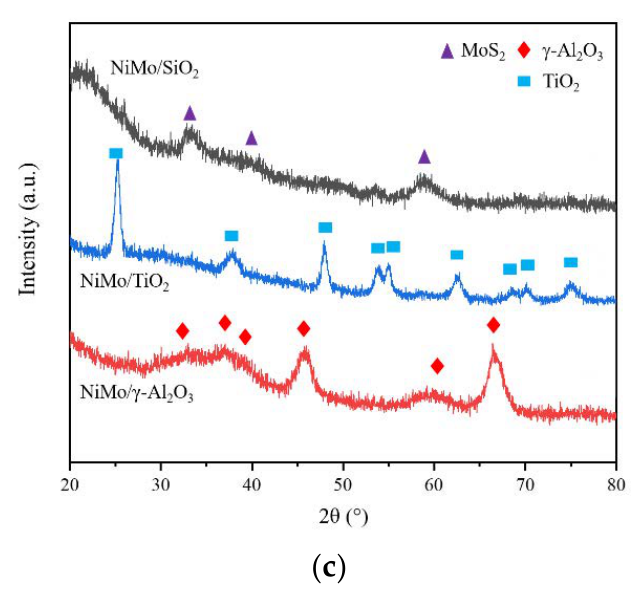
Figure 2. The XRD patterns of the calcined ( a ), sulfide ( b ), and post-run ( c ) of NiMo/SiO 2 , NiMo/TiO 2 , and NiMo/ γ - Al 2 O 3 catalysts.